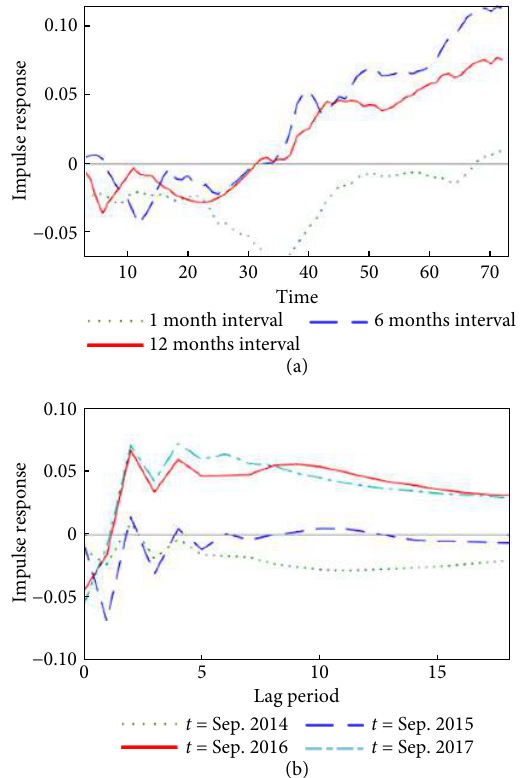
Fig. 5 Equidistant (a) and time-point (b) impulse responses of Index to Chang_rate.